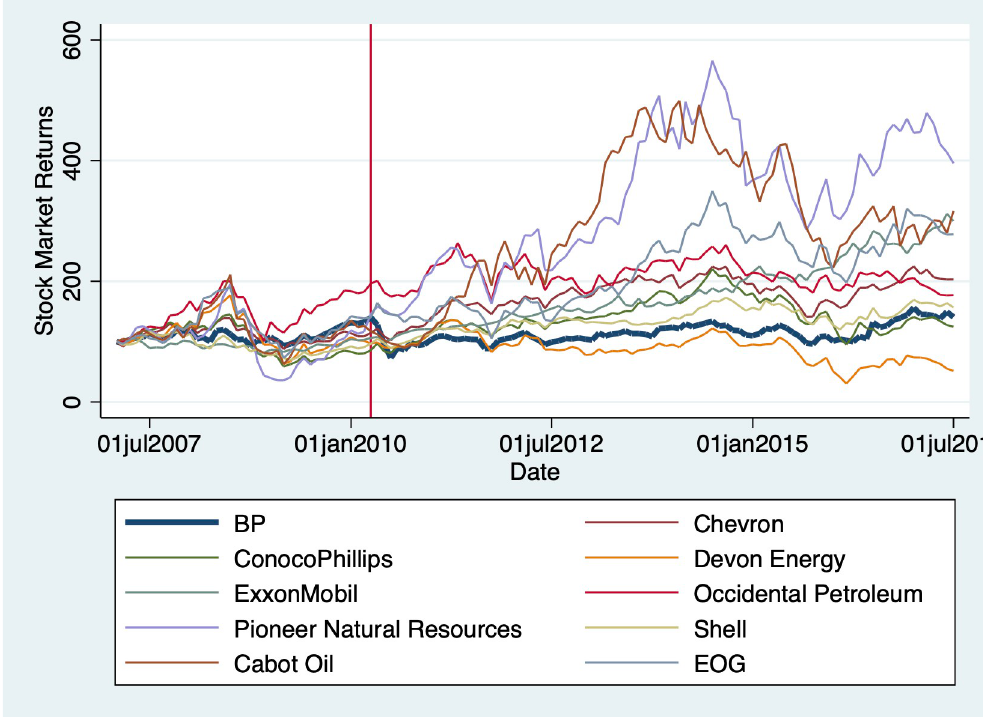
Fig 10. Market returns of oil and gas firms after deepwater horizon oil